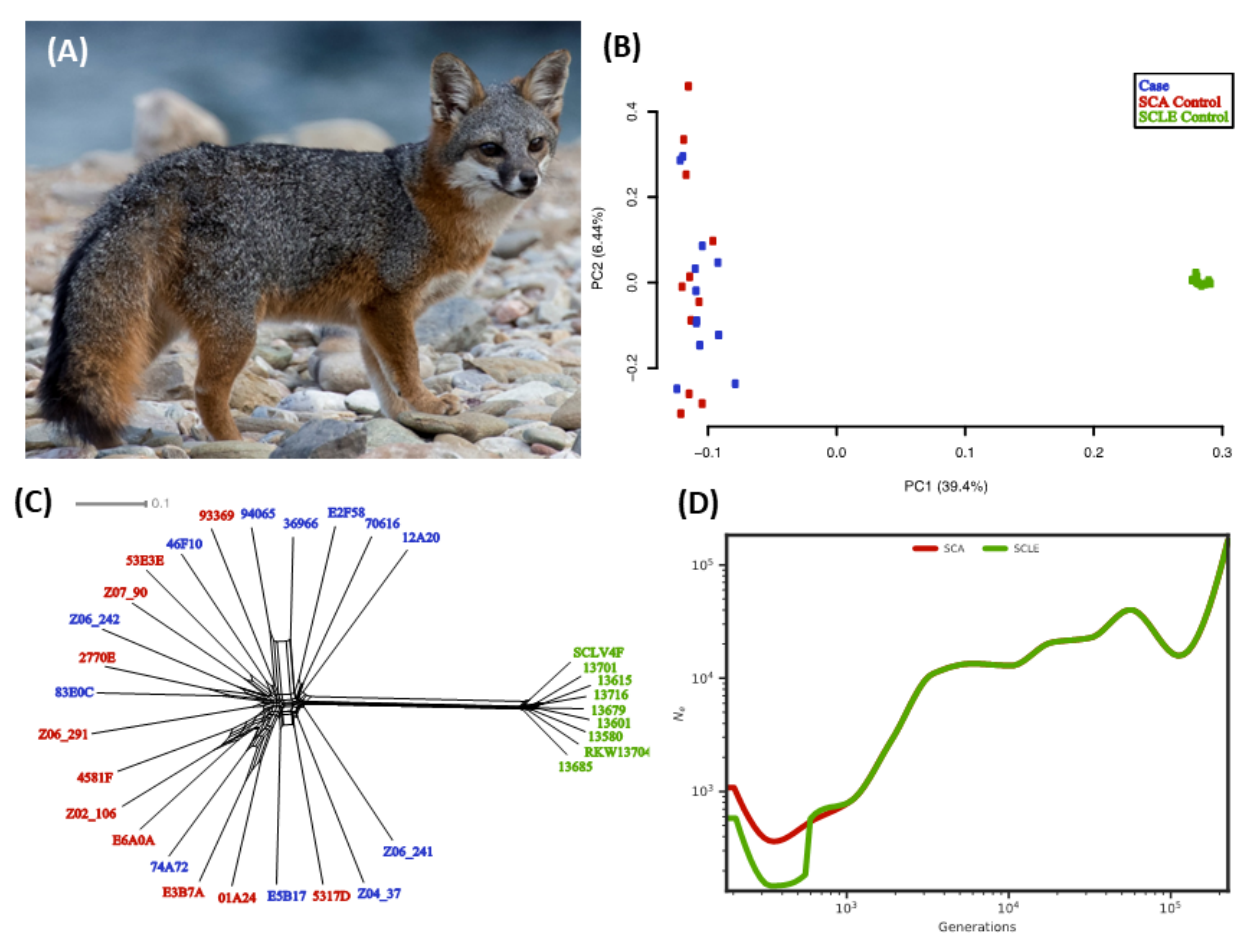
Figure 1. Catalina Island fox demographics. ( A ) Healthy island fox (photo credit Jaymi Heimbuch). Patterns of differentiation and divergence between populations using ( B ) PCA, and ( C ) Neighbor-net analysis. Case individuals are shown in blue, Santa Catalina Island (SCA) controls in red, and San Clemente Island (SCLE) controls in green. ( D ) Effective population size (Ne) over time calculated from single nucleotide variant (SNV) genotypes within neutral regions. A 2 year generation time and a mutation rate of 2.0 × 10 − 8 /site/generation were assumed [2]. SCA individuals are shown in red and SCLE individuals in green.